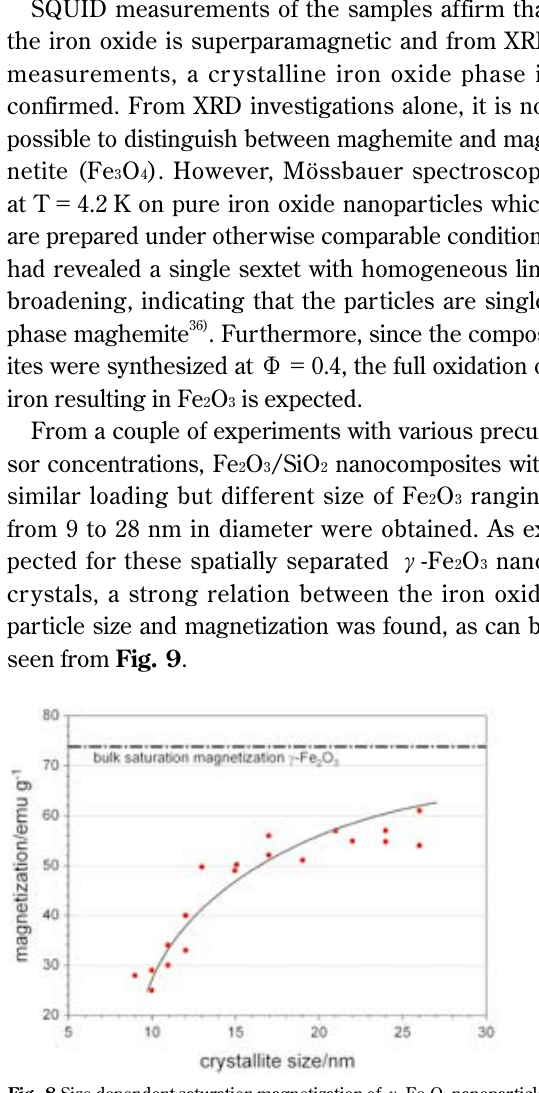
Fig. 8 Size-dependent saturation magnetization of γ -Fe 2 O 3 nanoparticles dispersed in a silica